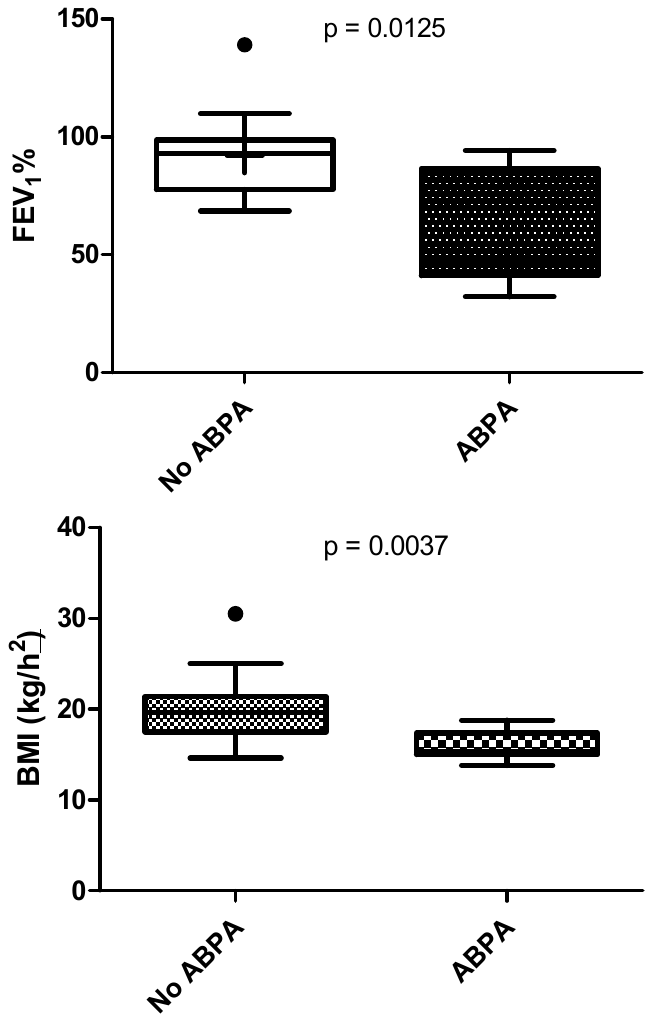
Figure 2. Difference in FEV 1 and BMI between patients with and without ABPA.